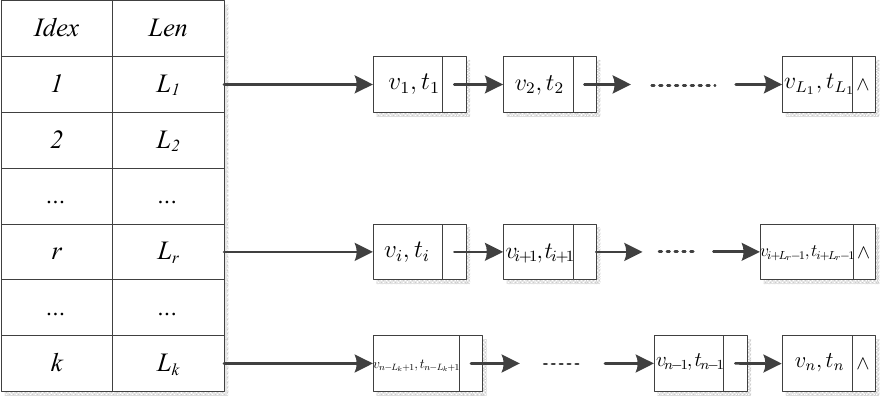
Figure 2. Divide and conquer hash